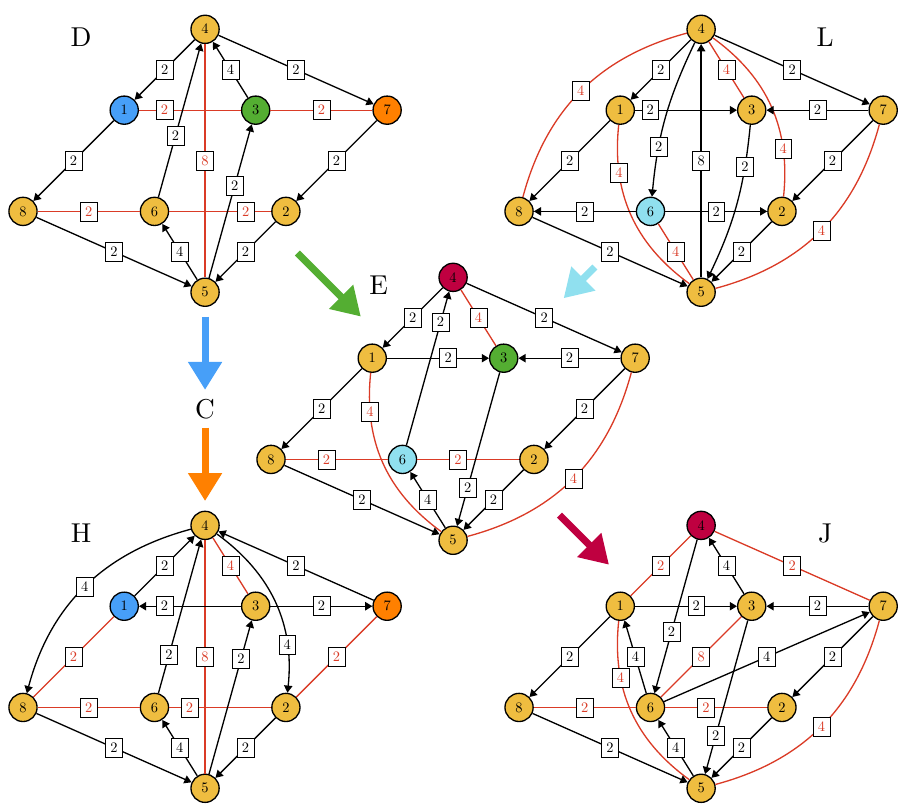
Figure 22 . N = (0 , 2) triality web for phases D, E, H, J and L of Q 1 , 1 , 1 / Z 2